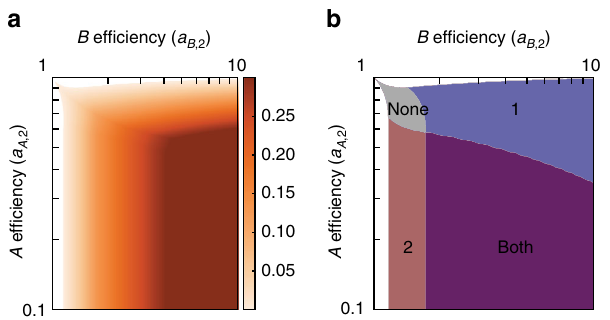
there is failure of coexistence. For example, when cells of type 2 are signi fi cantly worse at producing A than their counterparts but are only marginally better at producing B , then, the system tends toward an equilibrium where cell type 2 goes extinct ( n 2 → 0).